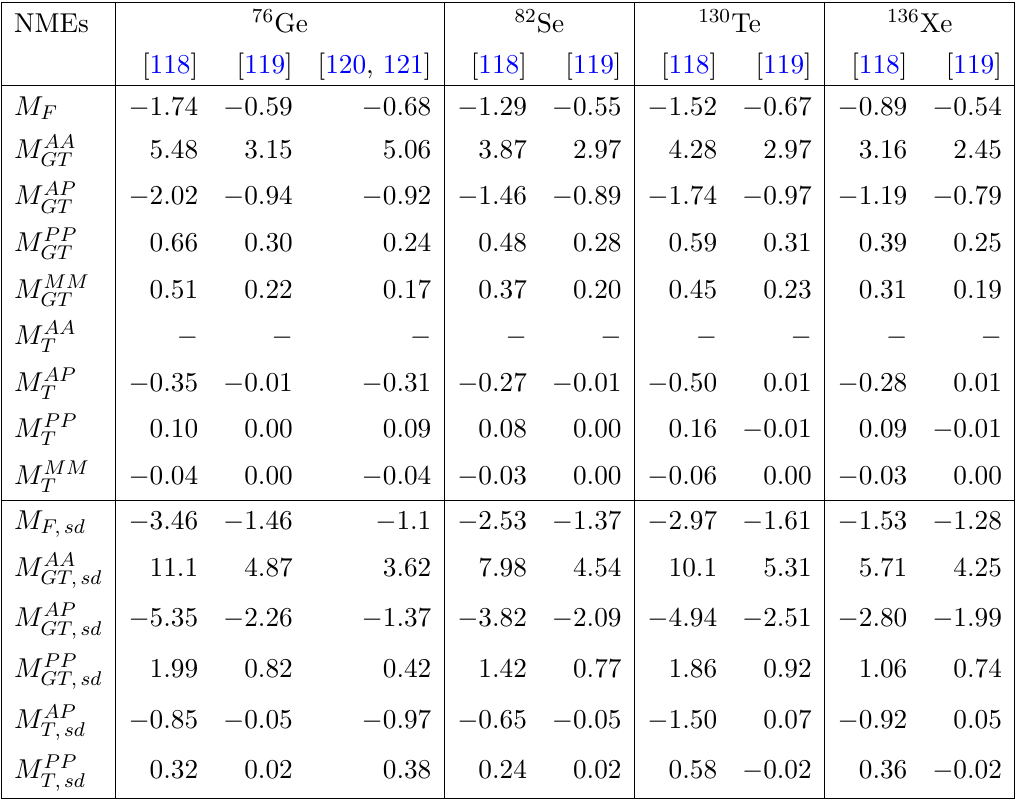
Table 7 . Comparison of NMEs computed in the quasi-particle random phase approximation [118], shell model [119], and interacting boson model [120, 121] for several nuclei of experimental interest. All NMEs are evaluated at m i = 0. The NMEs are de(cid:12)ned in eq. (6.2).